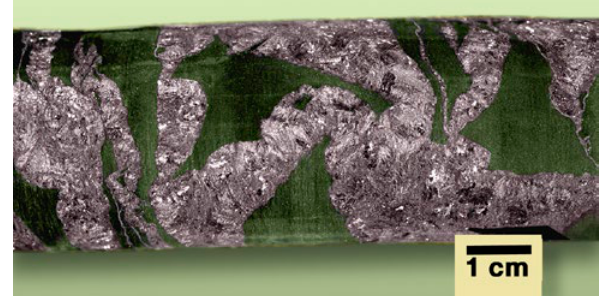
Figure 80. A complex ptygmatic haematite vein system has intrud- ed into the marginal chloritic sediment at the One-Oh-One pros- pect near the Orlando Mine, Tennant Creek. The massive crystal- line specularite contains slivers of chlorite wall-rock and the ptyg- matic folding indicates that the precursor ferric-hydroxide was col- loidal at the time it was intruded (viscosity dependant on the rate of flow).